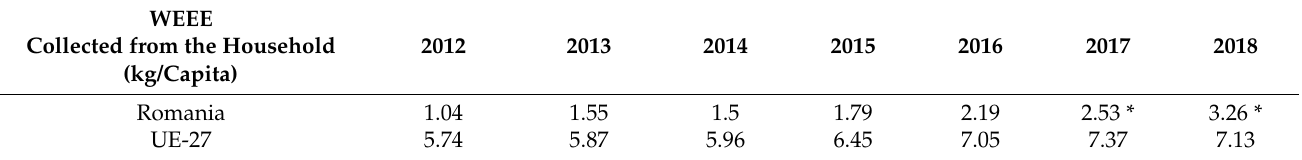
Table 3. Waste electrical and electronic equipment collected from the household in Romania and UE-27